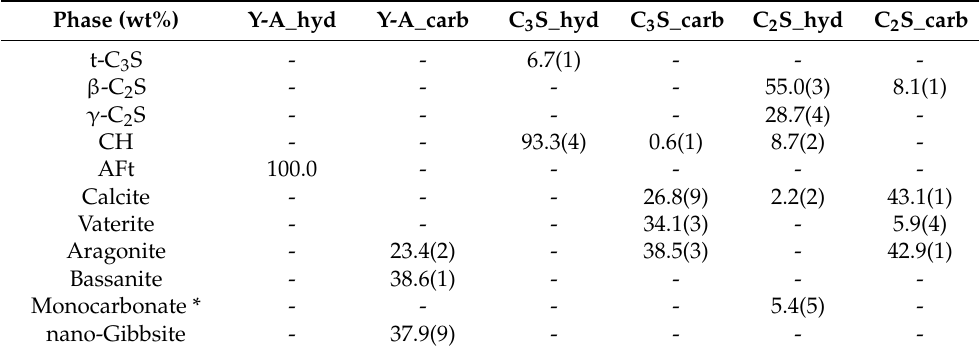
Table 4. Results of the Rietveld quantitative phase analyses of the synchrotron X-ray total scatter- ing